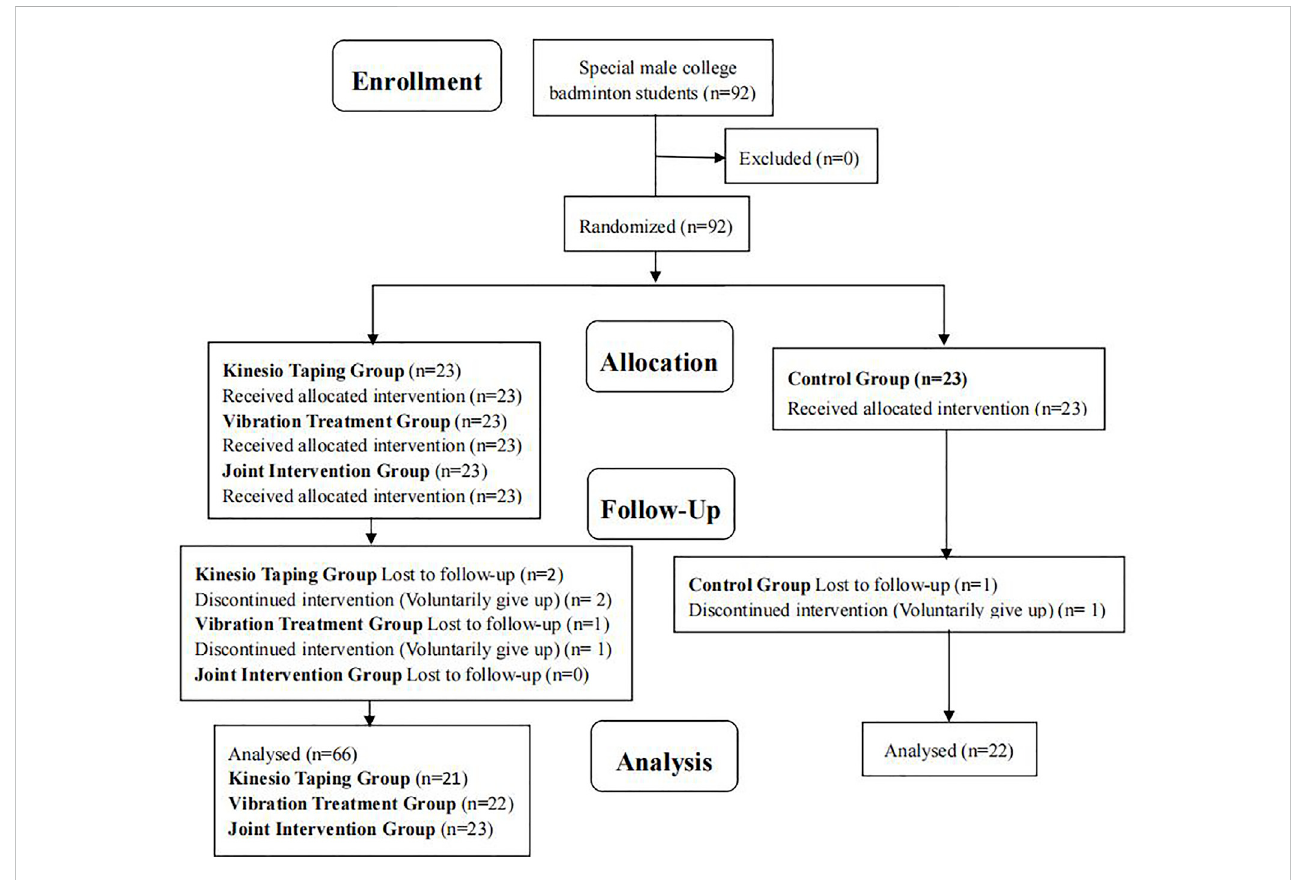
FIGURE 1 Participant selection fl ow